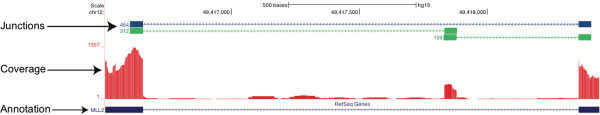
MLL2 is a disease-relevant gene in which a novel exon that constitutes a major transcript isoform was detected. The scale is provided by the bar at the top of the figure. The numbers shown indicate position on chromosome 12. The green bars in the junction track are the novel splice junctions, the blue bars are the current annotation of the splice junction. The red coverage track shows depth of sequence coverage, and the RefSeq track at bottom shows the current annotation for this portion of MLL2.